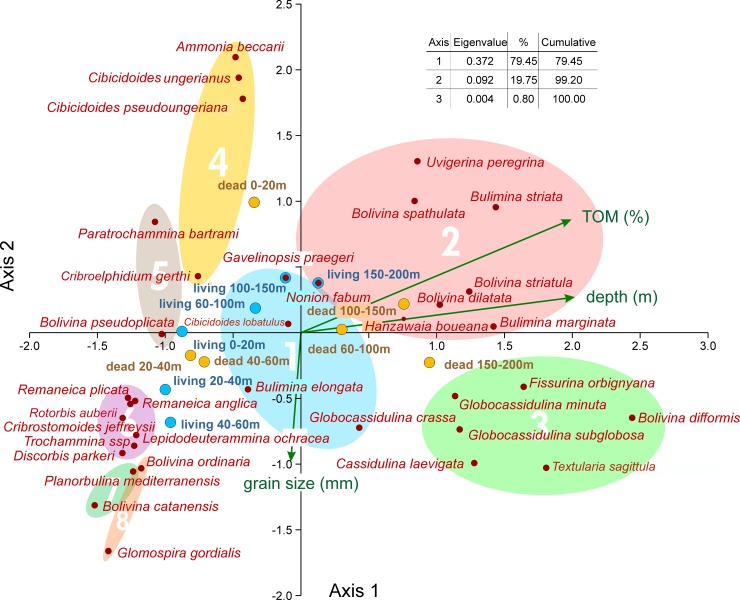
Canonical correspondence analysis of the most abundant species based on depth distributions of living and dead individuals.Groups are obtained by hierarchical cluster analysis Unweighted Pair Group Method with Arithmetic Mean using Cosine measures.